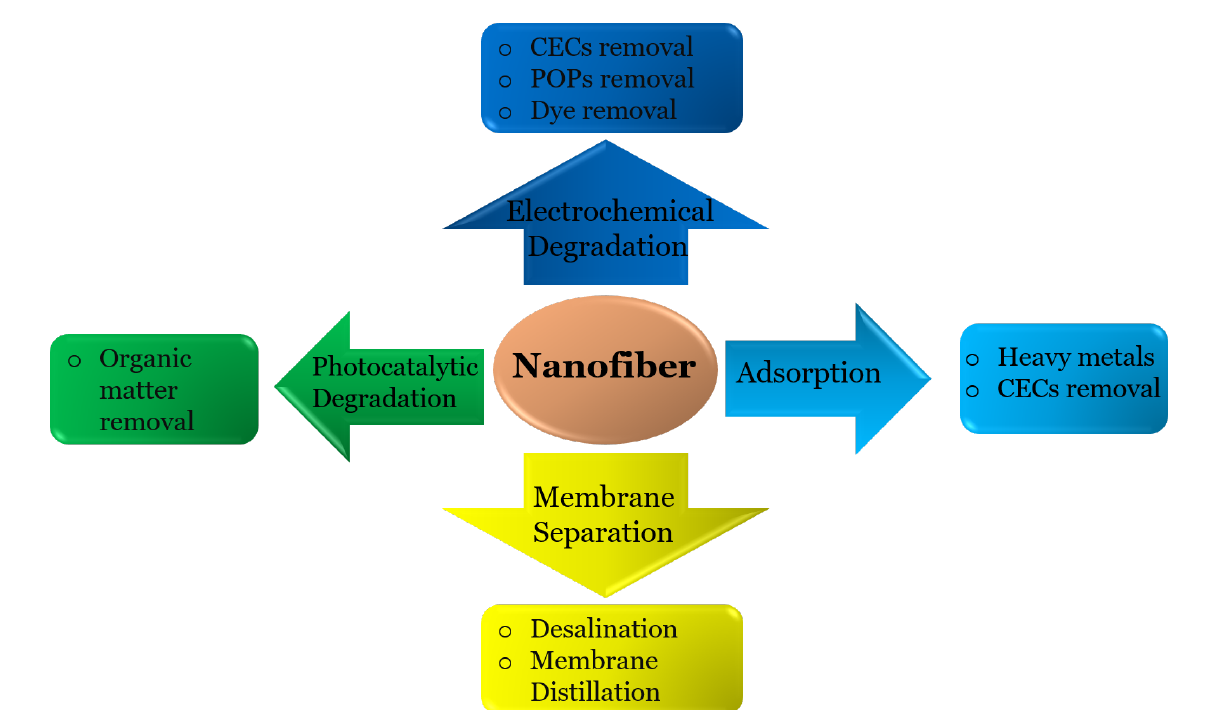
Figure 4. Water treatment applications of nanofibers.